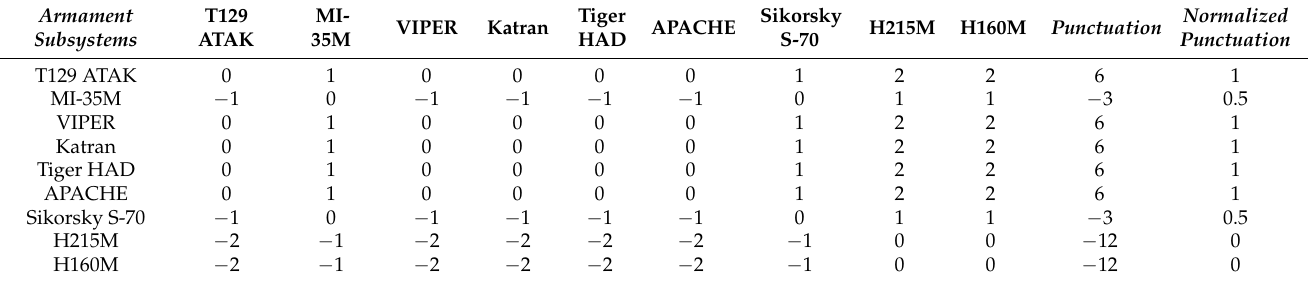
Table 8. Evaluation of alternatives under qualitative criterion Armament subsystems